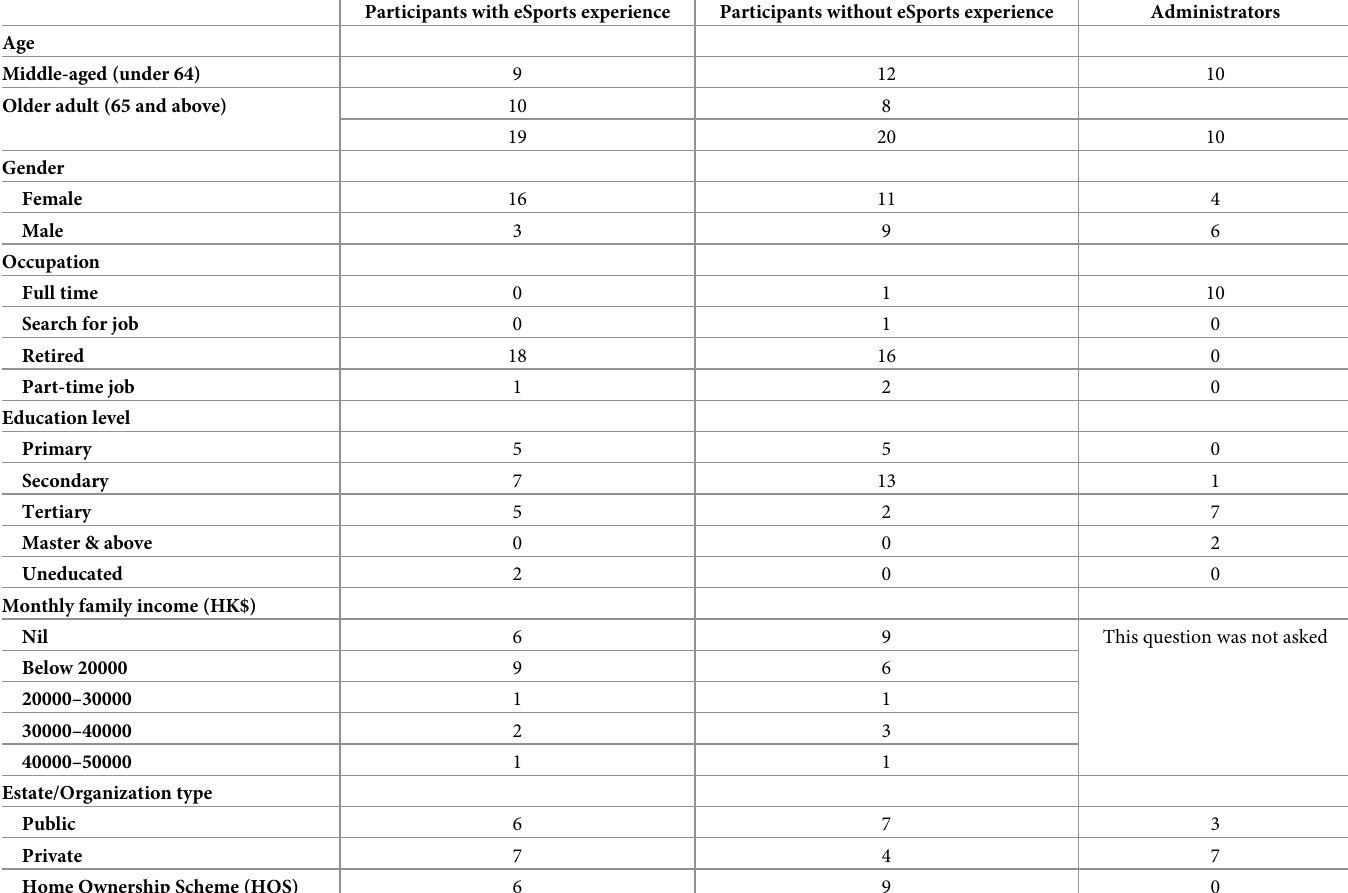
Table 1. Sociodemographic characteristics of participants (n =